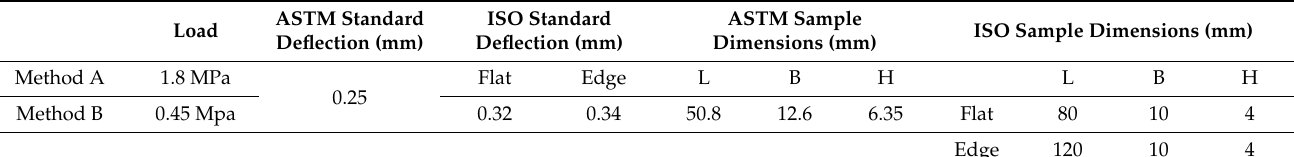
Table 2. ASTM/ISO standard dimension of the heat deflection